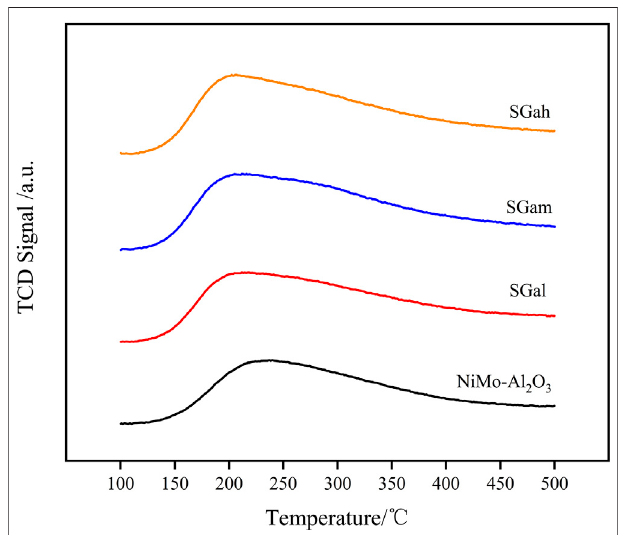
FIGURE 4 | NH 3 -TPD patterns of impregnated Ga-modi fi ed Ni – Mo/ Al 2 O 3 : (a) Ni – Mo/Al 2 O 3 , (b) SGal, (c) SGam, (d) SGah.